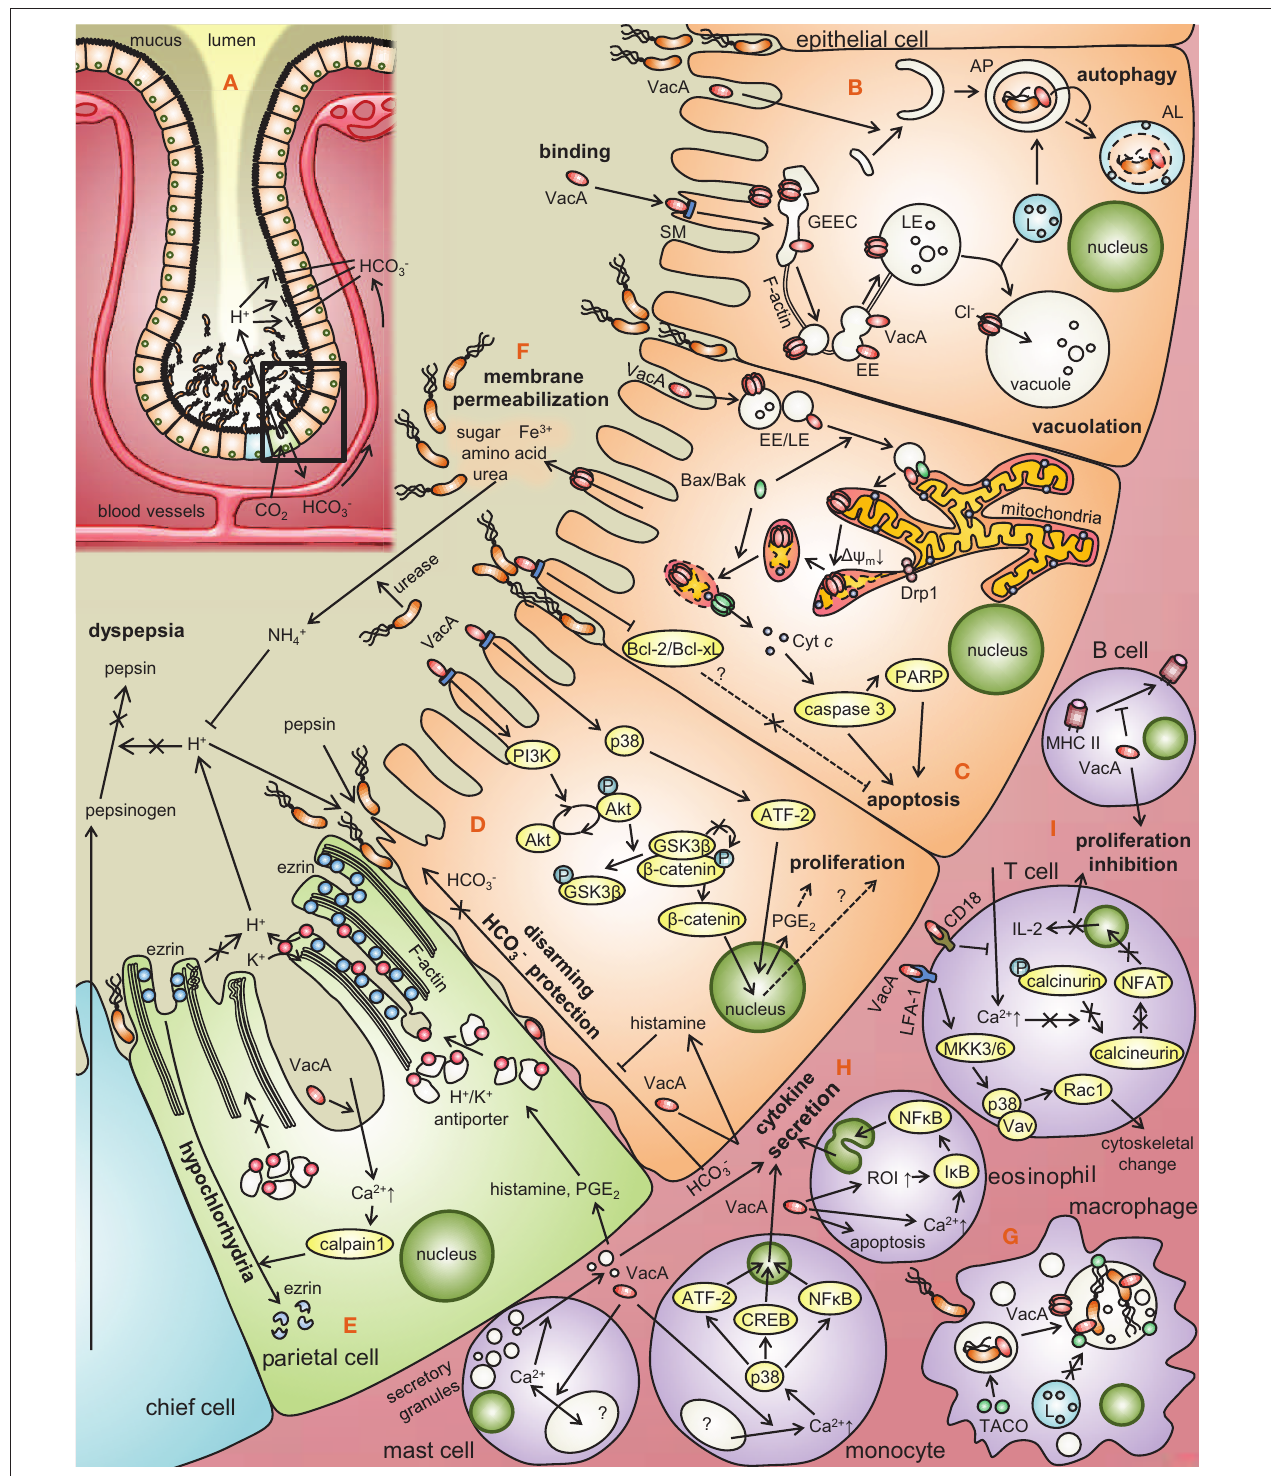
FIGURE 2 | Modulation of gastric cell functions by VacA. (A) Distribution of H. pylori at the gastric epithelium. Approximately 80% of H. pylori localize to the layer of mucus overlaying the epithelial membrane, while the remainder attach to the membrane surface as microcolonies. (B) VacA binds to epithelial cell surface receptors (SM, RPTP-a/ β ), and is taken up by a